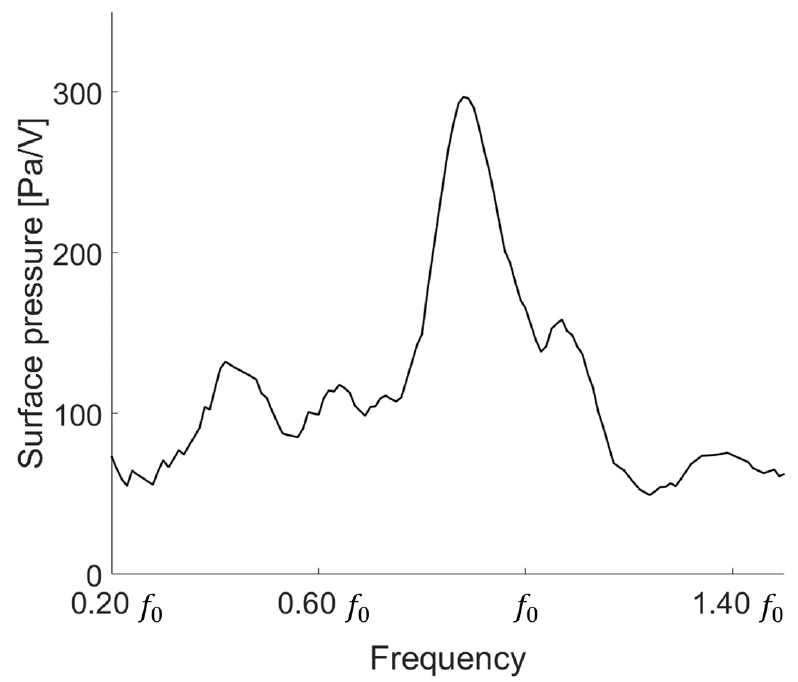
Figure 8. Surface pressure of the low-frequency transducer.